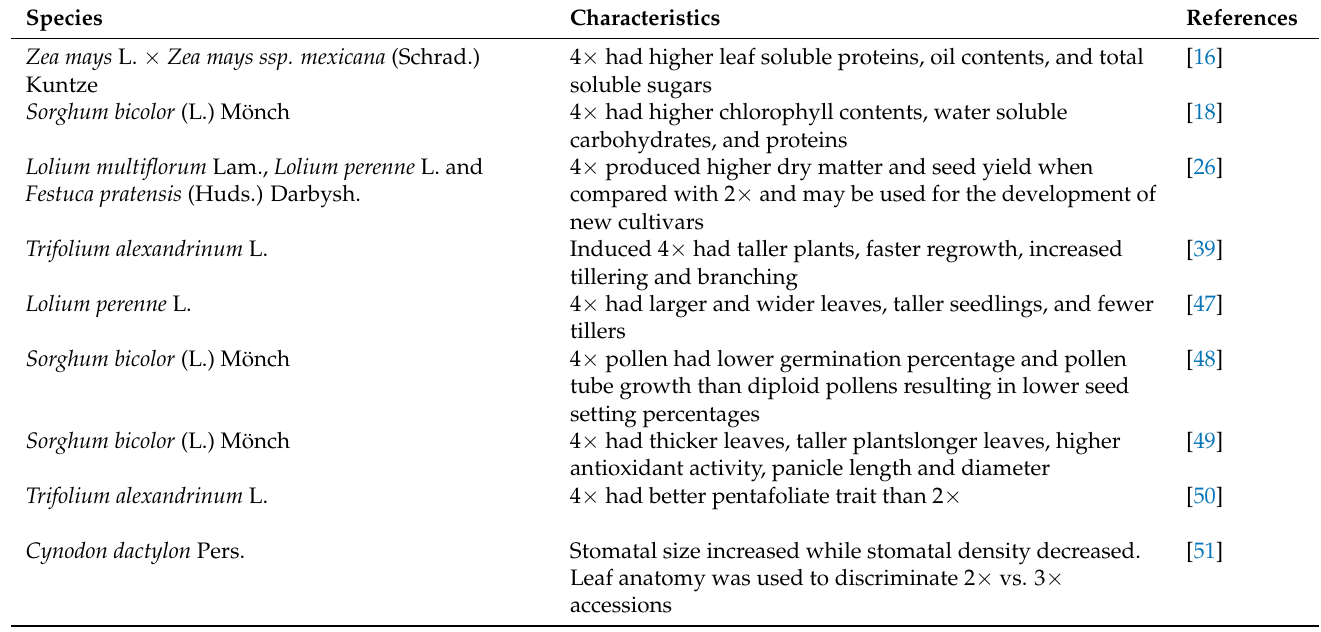
Table 2. Impact of induced polyploidy on forage traits in various